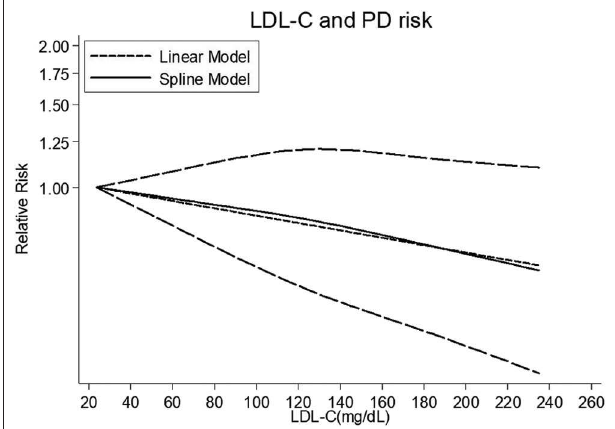
FIGURE 6 | Dose-response relationship between serum LDL-C levels and risk of PD. LDL-C, low-density lipoprotein cholesterol; PD, Parkinson’s disease.